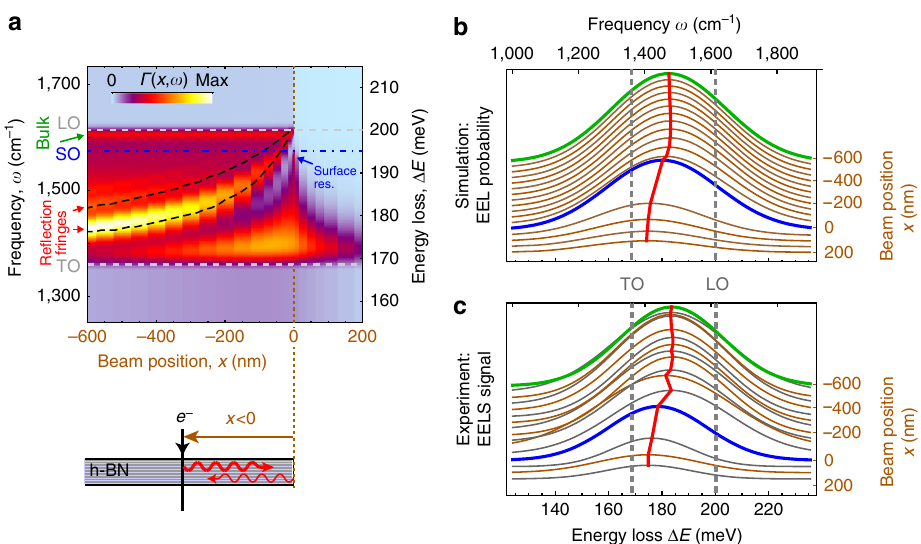
Fig. 6 Electron energy loss spectra near fl ake edges. a Numerically calculated (Comsol) EEL probability spectra for 30-nm-thick semi-in fi nite h-BN slab as a function of distance to its edge. Black dashed curves trace the interference fringe maxima appearing due to re fl ection of the guided volume polaritons from the slab edge (schematically shown at the bottom) calculated using Eq. (6) with re fl ection phase ϕ re fl = π /2. b Spectra extracted from a , but after convolution according to Eq. (5). The spectra are offset vertically for better visibility. Red line marks the position of the peak maximum. Blue spectrum corresponds to the convolution of the solid blue spectrum in Fig. 5a. Vertical dashed lines mark the TO and LO phonon energies. c Gaussian fi ts to the experimental STEM-EELS spectra for different beam positions near the edge of the 30 nm thick part h-BN fl ake. The spectra are collected along the orange line marked in Fig. 1a (see Methods). Red line marks the position of the peak maximum, ω